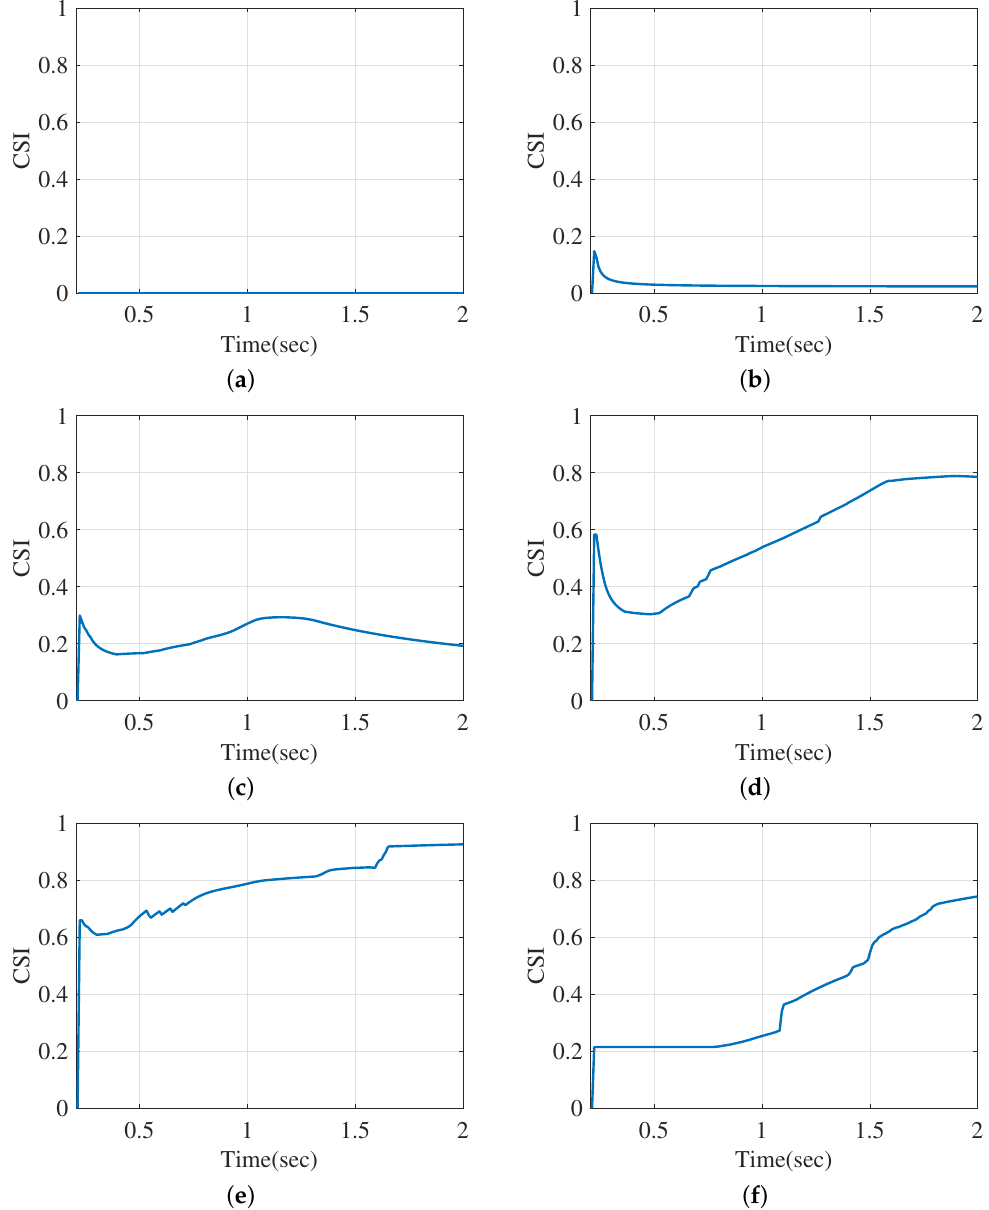
Figure 5. CSI calculated for defined scenarios: ( a ) Case a, ( b ) Case b, ( c ) Case c, ( d ) Case d, ( e ) Case e, ( f ) Case